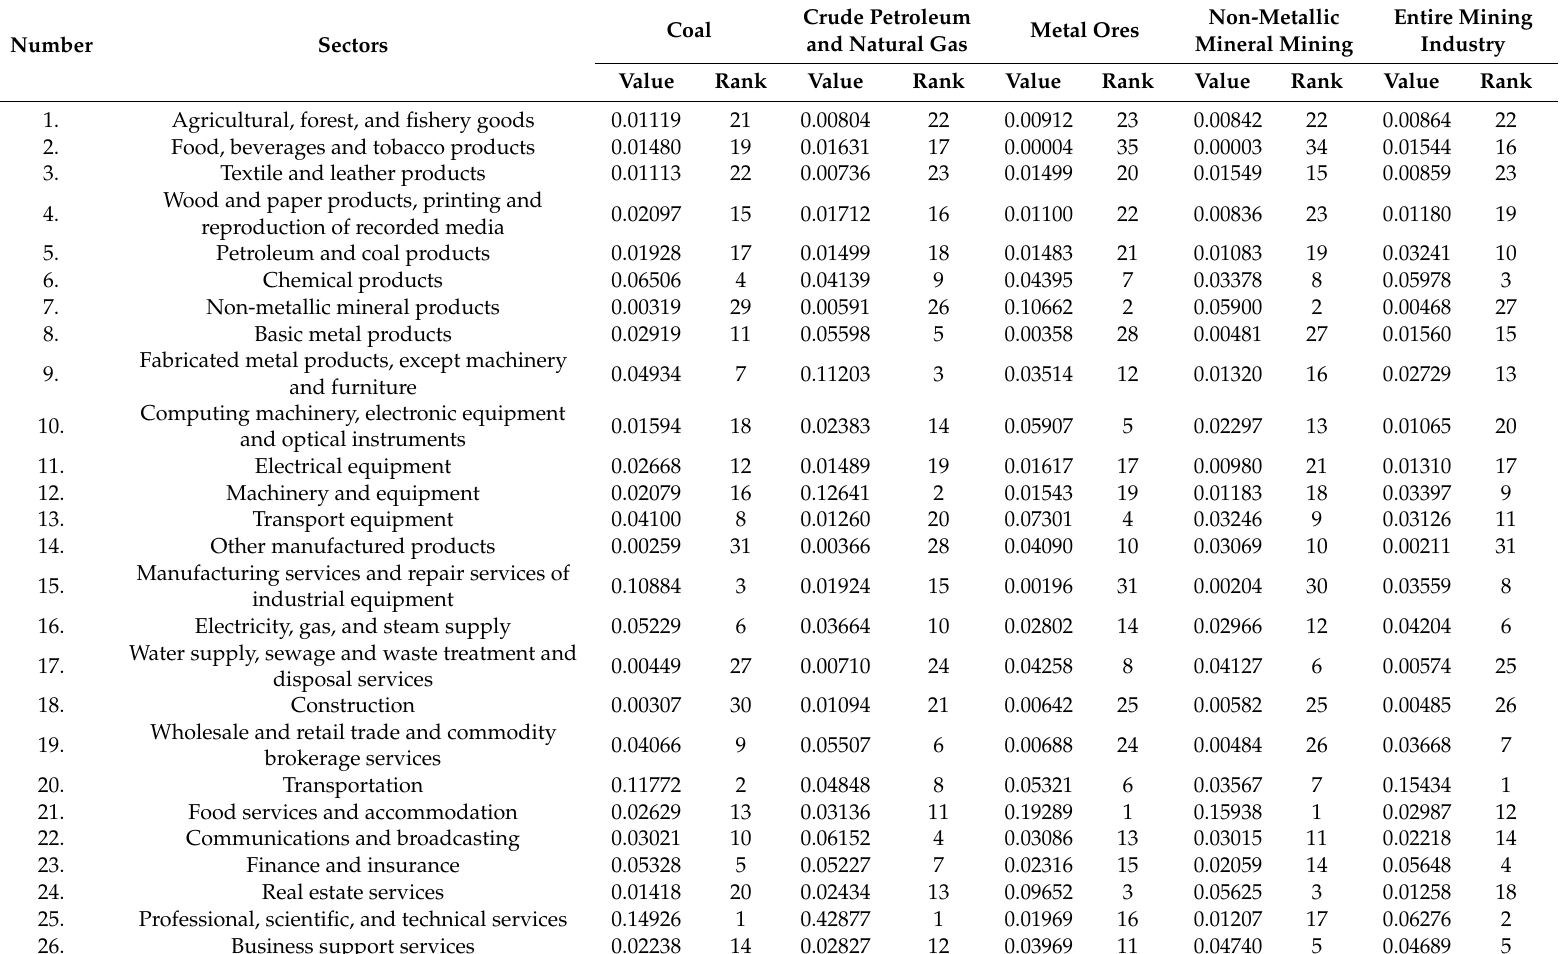
Table 2. Production-inducing e ff ects of mining